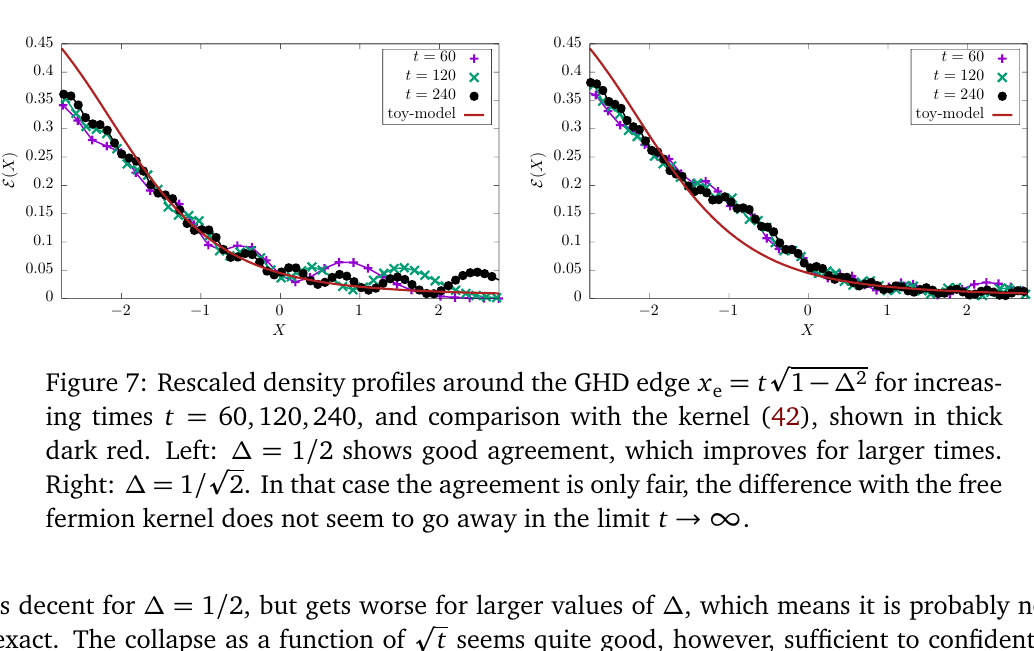
Figure 7: Rescaled density profiles around the GHD edge x ing times t = 60,120,240, and comparison with the kernel (42), shown in thick dark red. Left: ∆ = 1 / 2 shows good agreement, which improves for larger times. (cid:112) Right: ∆ = 1 / 2. In that case the agreement is only fair, the difference with the free fermion kernel does not seem to go away in the limit t → ∞